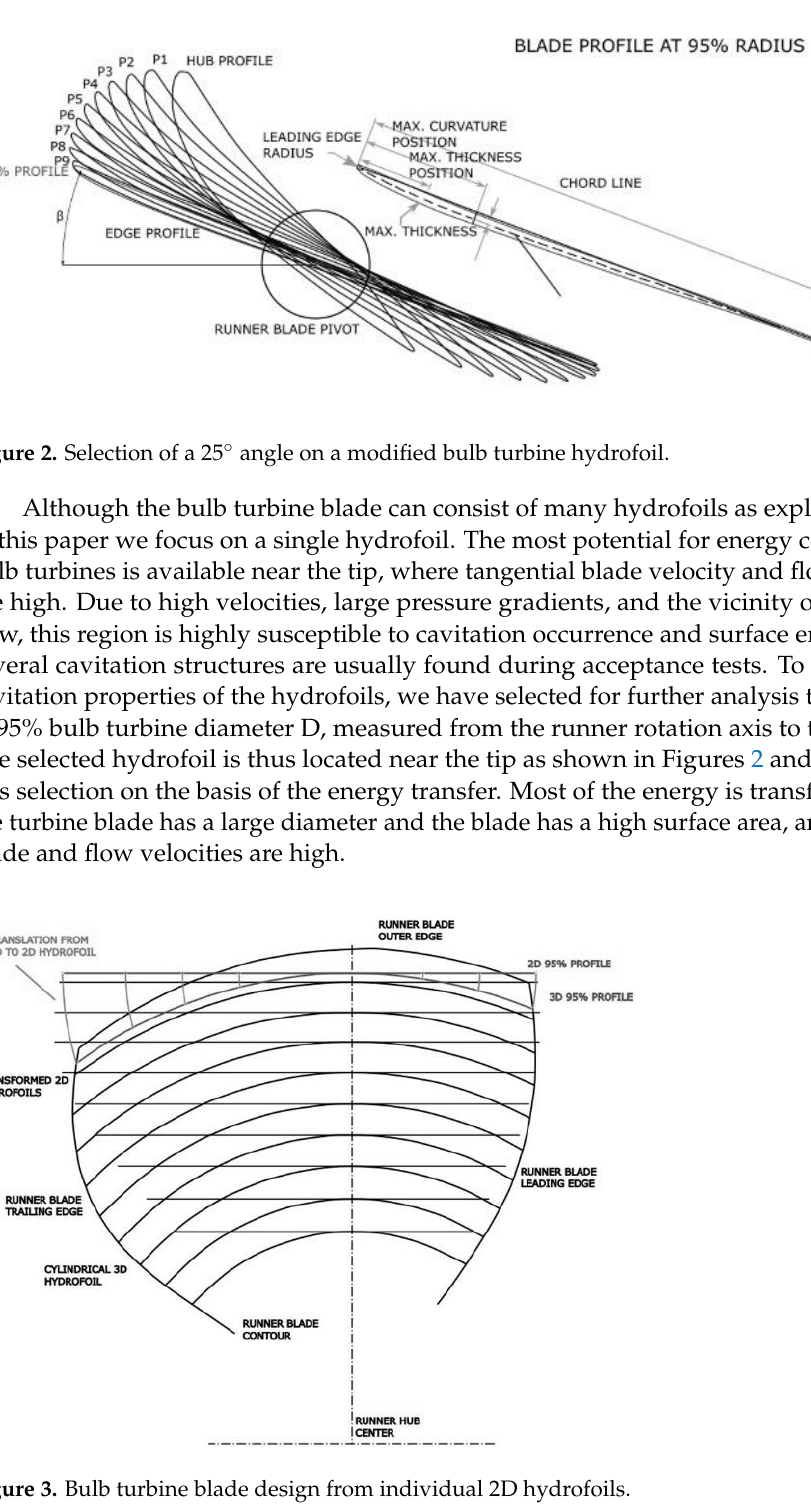
Figure 3. Bulb turbine blade design from individual 2D hydrofoils.